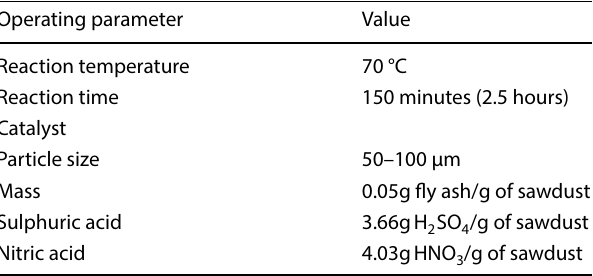
Table 1 Proposed conditions for the nitric acid oxidation of saw- dust with fly ash as